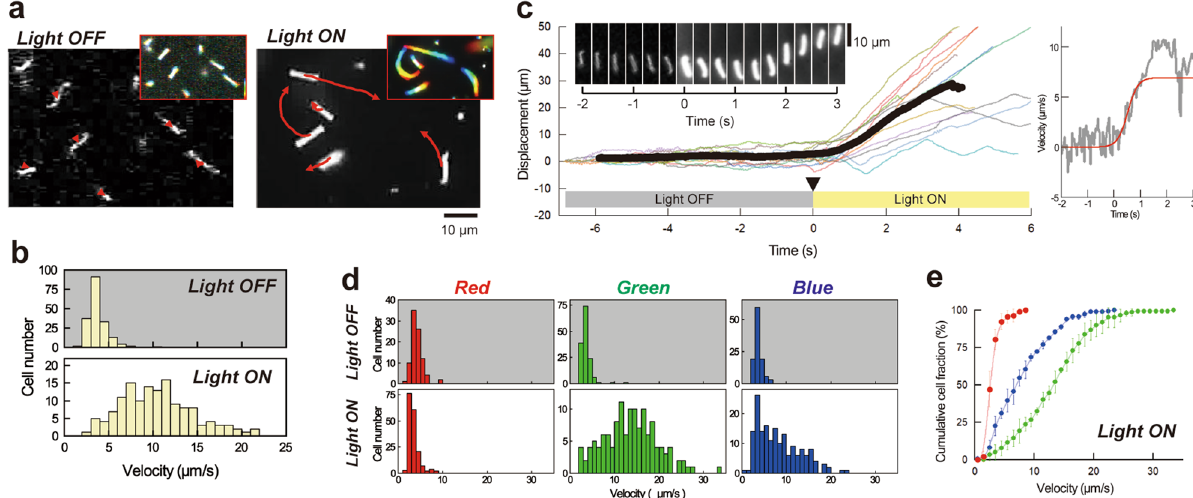
Figure 1. Light stimulation induces unidirectional swimming of spirochetal bacteria. (a) Swimming trajectories of Leptospira kobayashii cells under low-intensity (termed as “Light OFF” in this study) and high-intensity (termed as “Light ON”) illumination. The results of 2-s tracking are shown. Colored footprints (inset, time courses in the order from red to blue) show almost zero net migration in Light OFF. Note that the bacteria retain vigorous motility in Light OFF (see the scene “Light OFF” in Movie 1). As a light source, a halogen lamp was used with a wide band-pass filter (ca. 400–700 nm). (b) Velocities of individual cells measured in Light OFF (n = 189 cells) and in Light ON (n = 150 cells). The data were obtained by three independent experiments. (c) Time courses of cell displacement. Example traces obtained from 14 cells (thin colored lines) and the averaged trace (thick black line) are shown. Neutral density filters were removed at the time point (indicated by the triangle and set as 0 s) so that the cells were suddenly exposed to stronger light. The sequential micrographs (inset) show the light-dependent initiation of directional swimming. The right panel shows the time course of velocity (gray) obtained from the mean displacement and the result of sigmoidal curve fitting (red). (d) Color dependence of the light-controlled motility. Band-pass filters with center wavelengths of 650 nm, 550 nm, and 488 nm were used for red, green, and blue illumination, respectively. The experiments were repeated three times, and ca. 100 cells were measured in total in each condition. (e) Cumulative cell fractions calculated from the histograms of Light ON shown in ( d ). The colors indicate those used for illumination: average values (closed circles) and standard deviations (error bars) of three independent